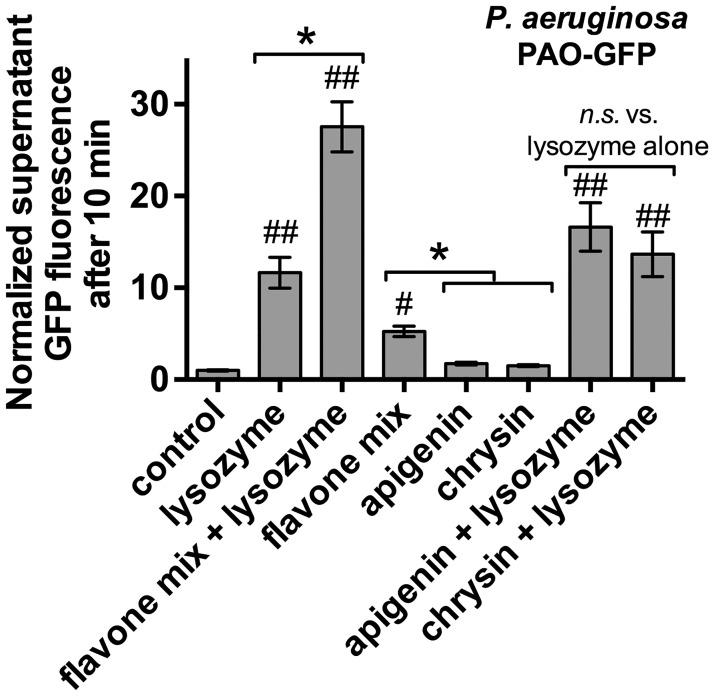
Confirmation of bacterial lysis by measurement of GFP release from PAO-GFP.Bar graph showing normalized fluorescence (control = 1) from PAO-GFP cultures incubated in lysozyme lysis buffer with addition of lysozyme and/or flavones as indicated and described in the text. Flavone mix contained 100 μM each apigenin, chrysin, and wogonin. Apigenin and chrysin were used alone at 300 μM to compare an equal number of moles of flavone molecules. Synergistic effects of the flavone mixture were observed both alone and combined with lysozyme. Significance determined by one-way ANOVA with Bonferonni post-test; # and ## indicate p <0.05 and p <0.01, respectively, compared with control; * indicates p <0.05 between bracketed groups.